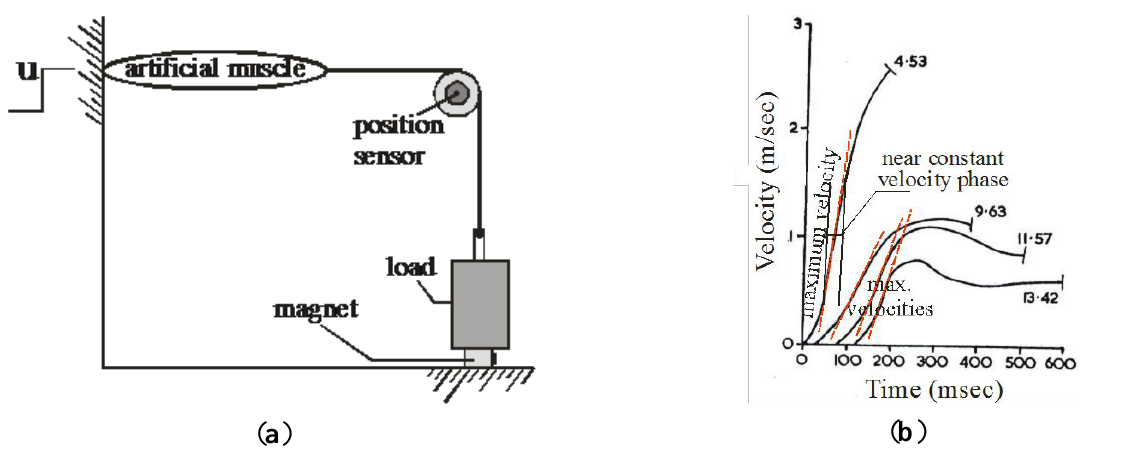
Figure 3. Use of the Hill-curve concept for defining the force-velocity characteristic of an artificial muscle, ( a ) Hill’s quick-release test considered as a “release trial” of the artificial muscle from zero position and velocity, with a constant u -control and given load, and ( b ) characterization of the corresponding velocity as the maximum velocity reached during contraction (redrawn from a typical skeletal muscle